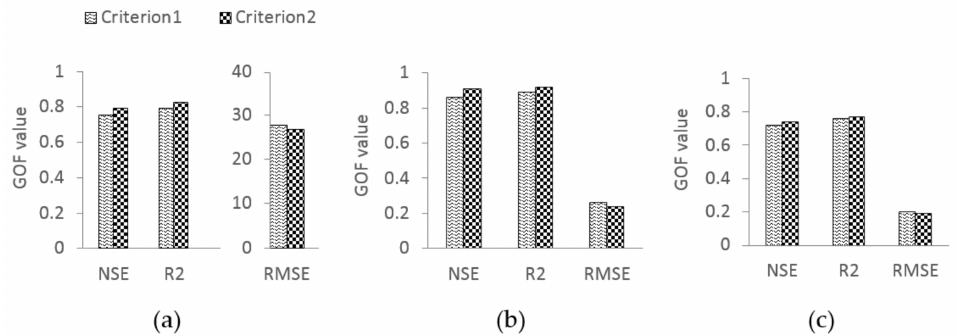
Figure 8. Comparison of calibration performance while modelling the variable demand patterns using daily multiplication factors (criterion 1) and linear models (criterion 2) ( a ) GOF for PS2 ( b ) GOF for Binnies tank and ( c ) GOF for Meningie